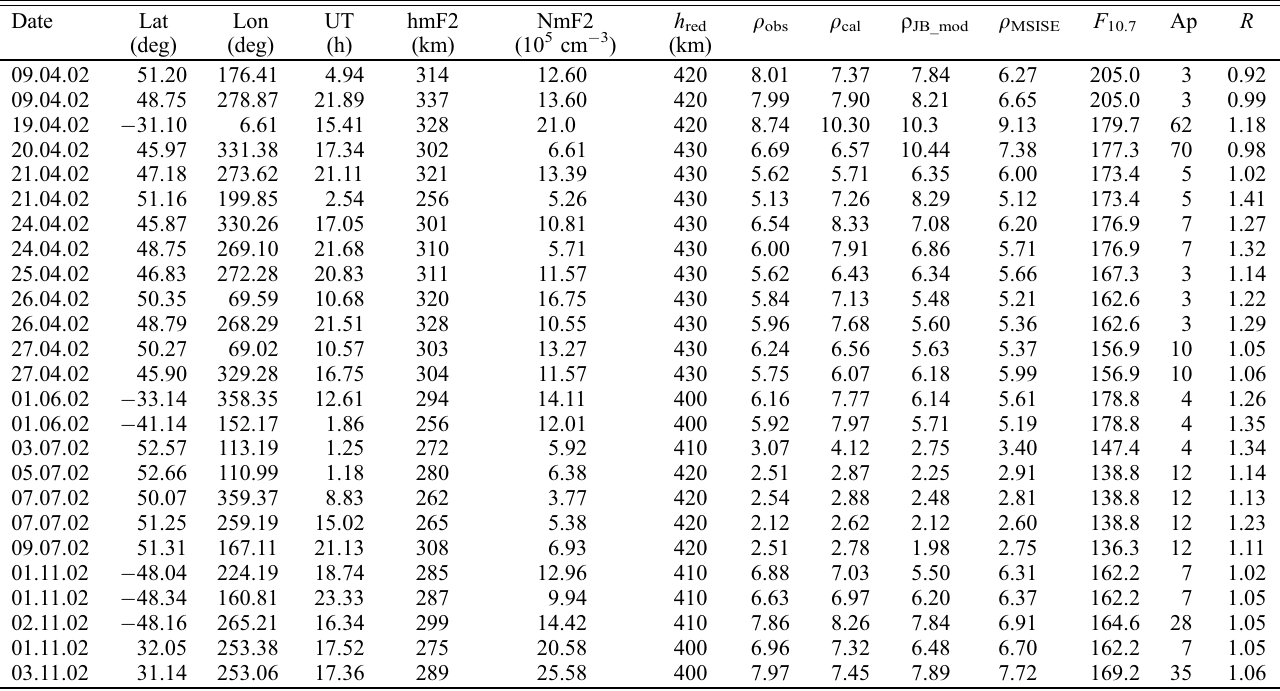
Table A4. Similar to Table A1 but for solar maximum activity.